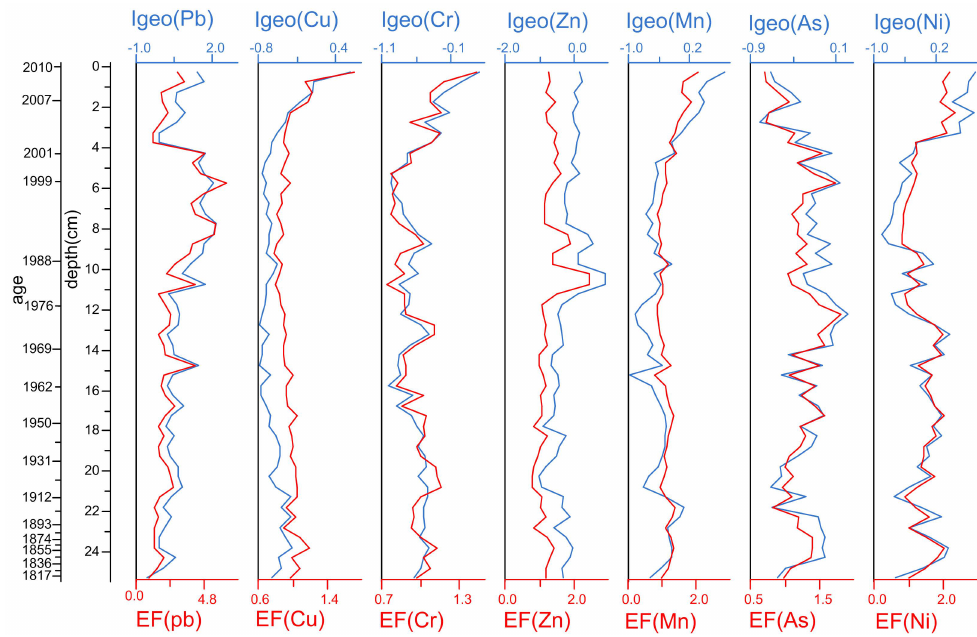
Figure 3. Geo-accumulation index (Igeo) and enrichment factor (EF) depth profiles of trace metals in the Lugu Lake sediment core. The blue and red lines represent Igeo and EF profiles respectively. Table 1. Igeo and EF classification in relation to sediment quality